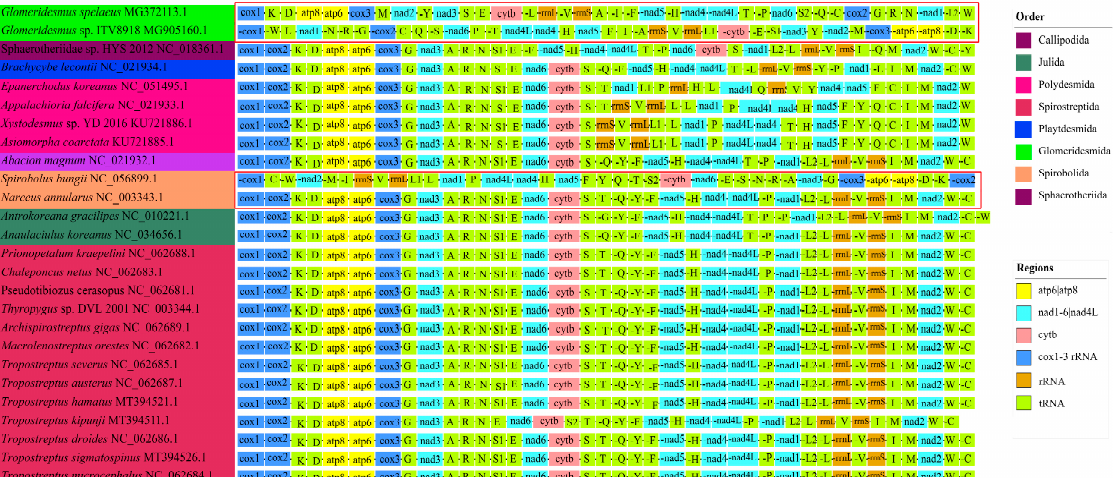
Figure 6. Gene arrangement image of Diplopoda mitogenomes.